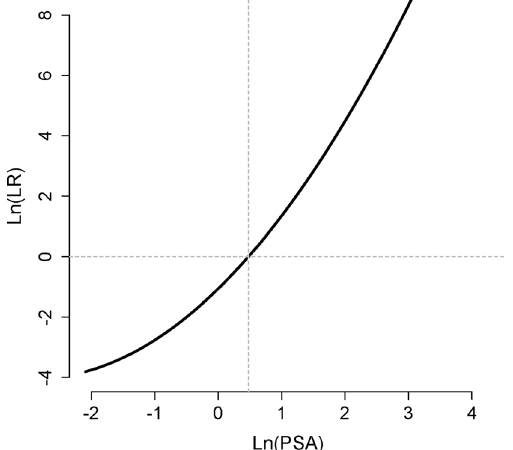
Figure 5. Likelihood ratio ( LR ) for various PSA values in 54–59-year-old men. Note that both axes are logarithms of the variables. The horizontal gray dashed line corresponds to an LR of 1; the vertical gray dashed line represents the cut-off value, PSA of 1.61